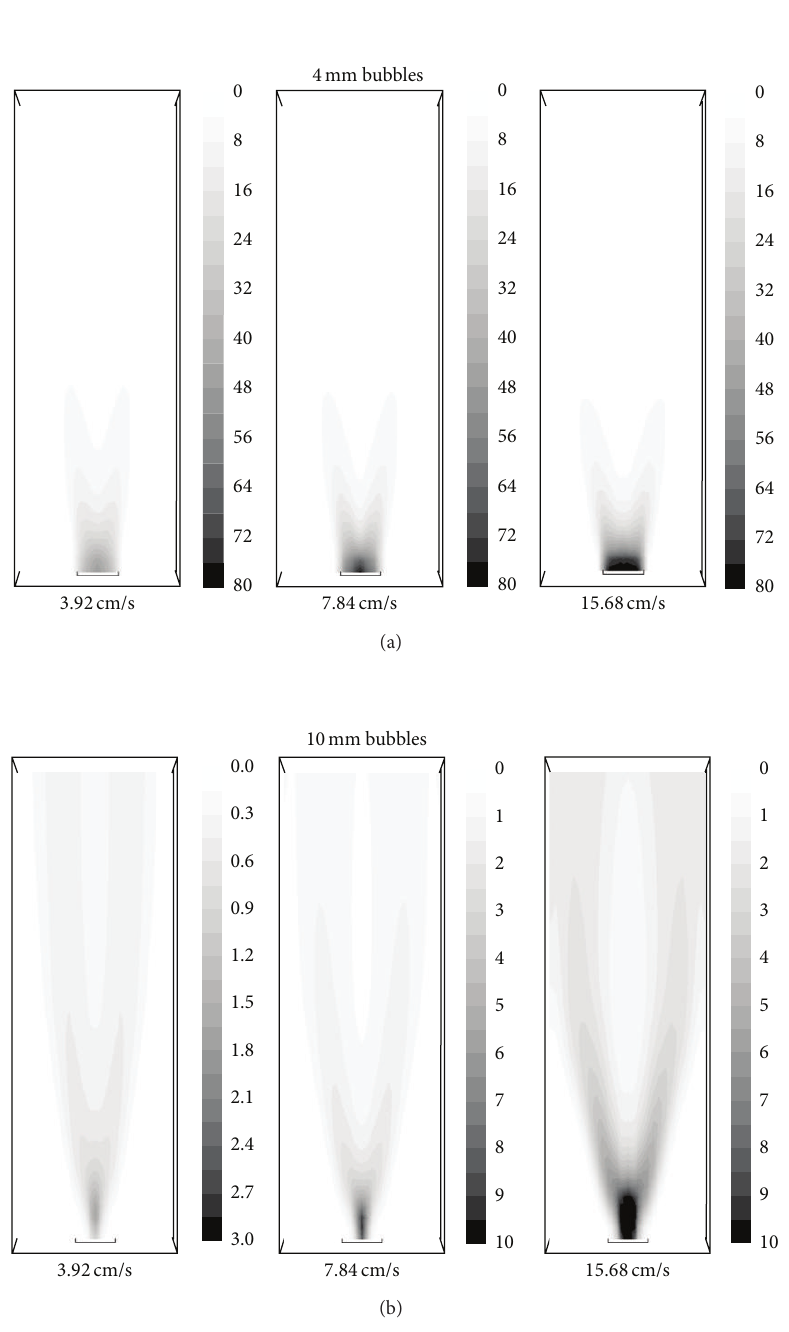
Figure 6: Variations in the scattering coefficients (in m −1 ) of the different sized bubbles as a function of inlet gas velocities in the TFM + population balance simulations: (a) 4mm bubbles; (b) 10mm